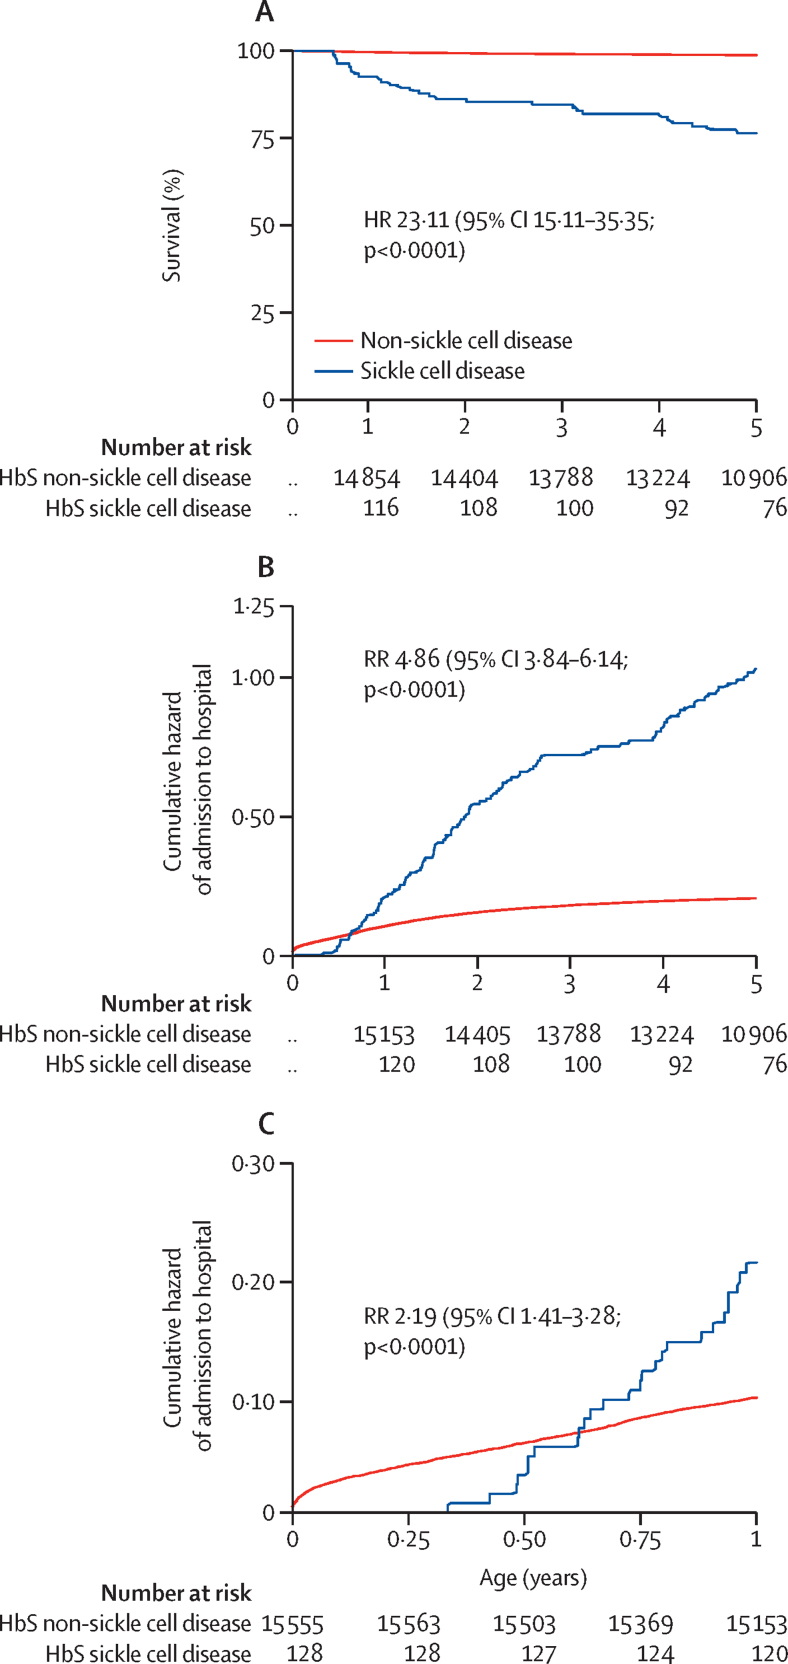
Survival probability and cumulative hazard of admissionKaplan-Meier mortality plot (A) and Nelson-Aalen cumulative hazard plots for admission to hospital over 5 years (B) and 1 year (C) in children with and without sickle cell disease. HR=hazard ratio. HbS=haemoglobin S. RR=rate ratio.